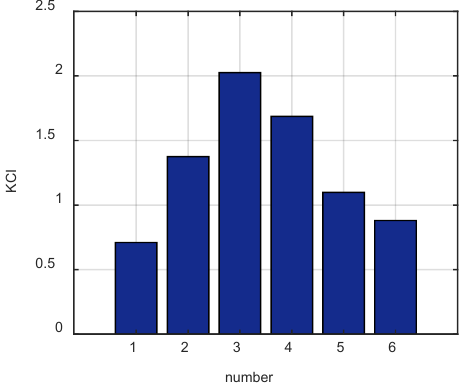
Figure 7. Histogram of the model obtained by KCI.